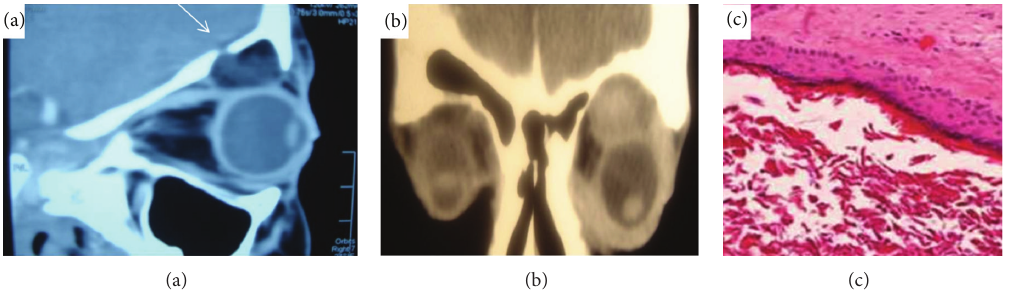
Figure 2: (a) Sagittal section showing a bony defect (arrow) in the orbital roof related to superior orbital cyst. (b) Superior homogenous cyst with widened orbital dimensions with obliteration of the frontal sinus. (c) Haematoxylin and eosin slide showing squamous epithelial lining with lack of skin appendages and keratin filling and chronic inflammatory cells in the wall.